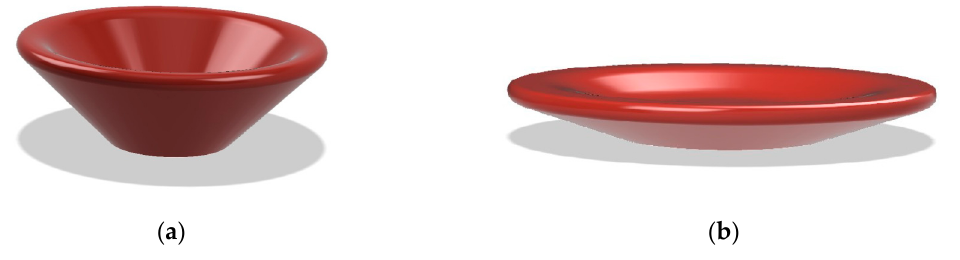
Figure 3. Object with overhang ( a ) less than 50 degrees, where generally no support is needed, and ( b ) greater than 50 ◦ , where supports are needed.